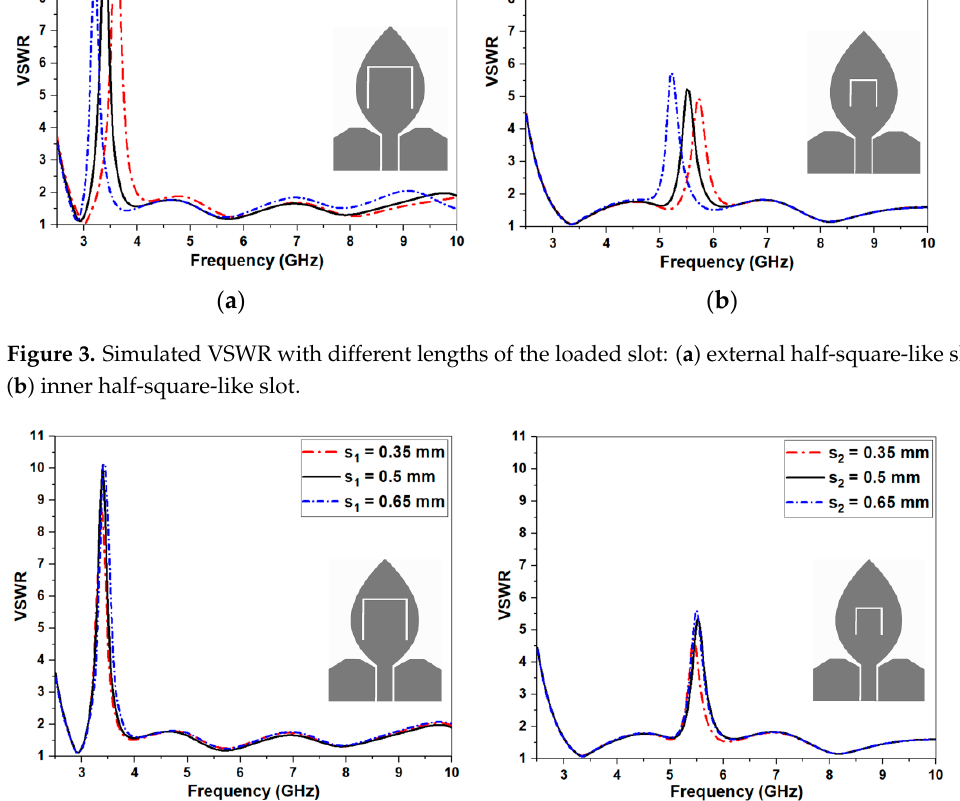
Figure 4. Simulated VSWR with different widths of the loaded slot: ( a ) external half-square-like slot; ( b ) inner half-square-like slot.